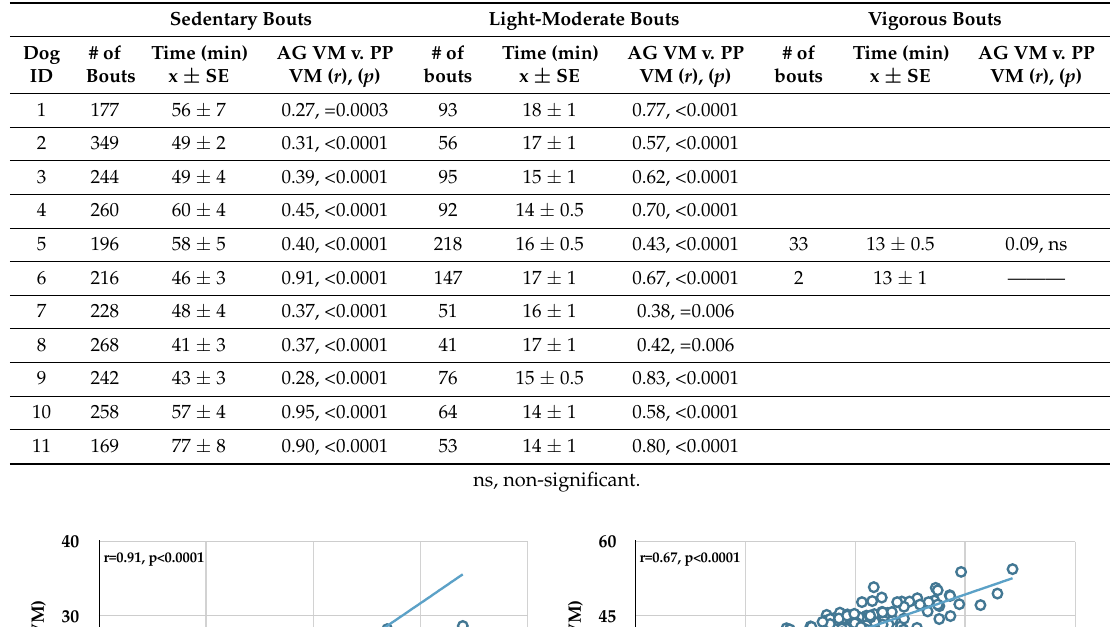
Table 2. Number of days in study, number of bouts and average time spent per bout, and relationships between ActiGraph activity data (vector magnitude, AG VM) and PetPace data (vector magnitude, PP VM) during sedentary, light-moderate, and vigorous bouts.